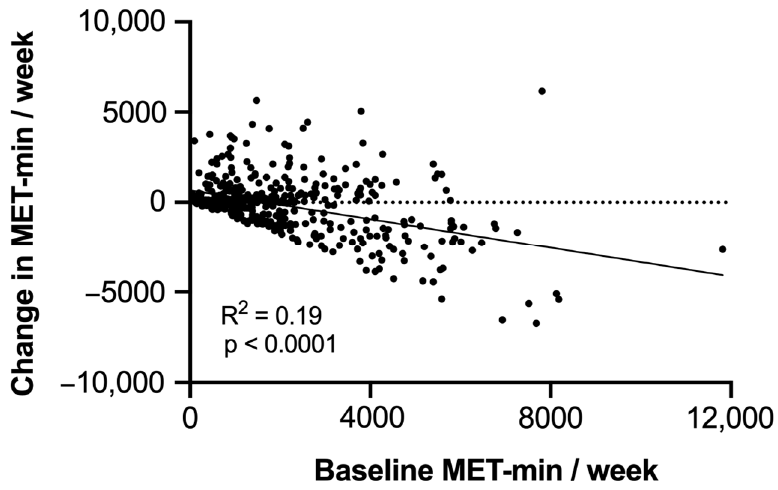
Figure 1. Correlation between the baseline PA levels (before lockdown) and the change in the PA levels as measured by MET-min/week.